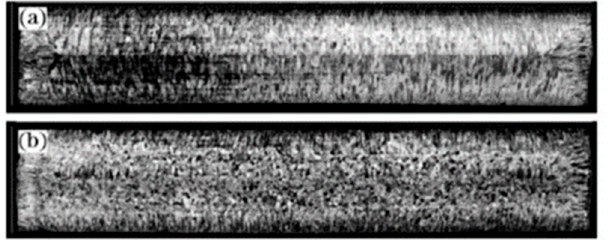
Figure 26. Microstructure of nonoriented electrical steel in slab horizontal cross-sections ( a ) without and ( b ) with SEMS rollers (54% equiaxed grains) [42].